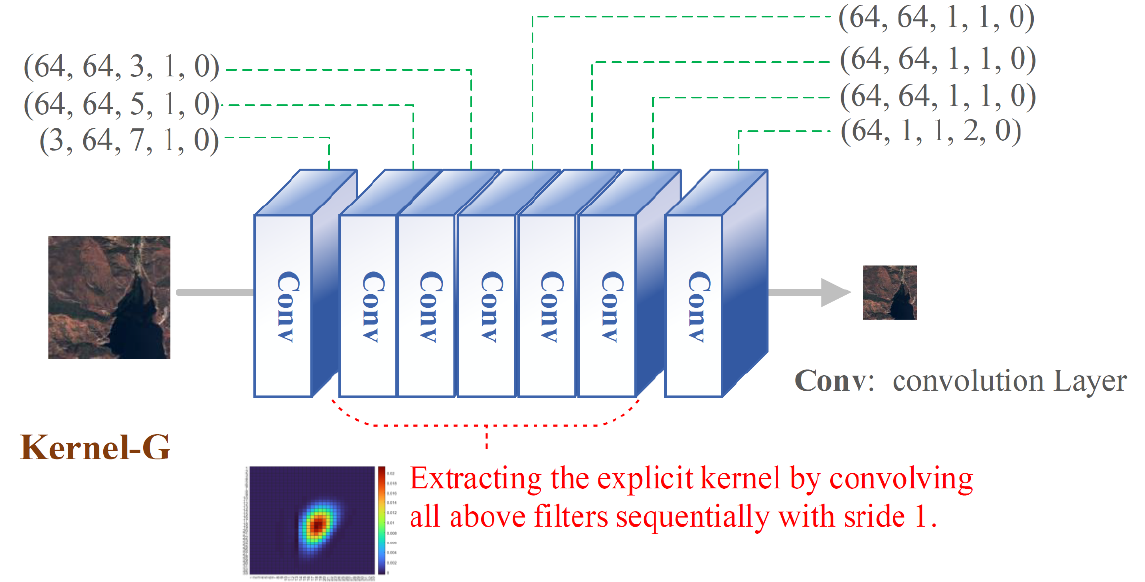
Figure 4. Network structure of the kernel generator consisting of a multi-layer linear convolution layer.